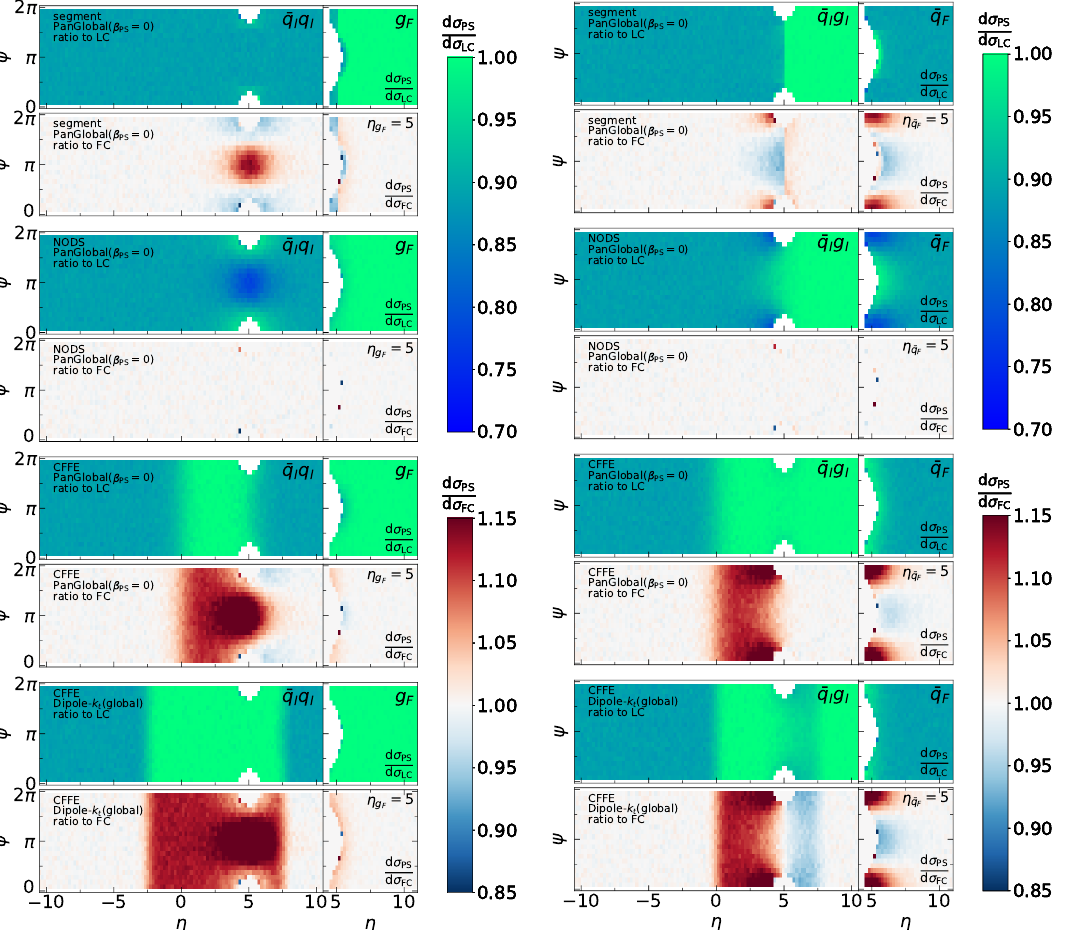
Figure 8. Density for the emission of a soft gluon from a q I ¯ q I → Zg F (left) or g I ¯ q I → Z ¯ q F (right) system in the rapidity-azimuth plane. From top to bottom, the rows show the segment, NODS and CFFE methods with the PanGlobal shower, and the CFFE method with the Dipole- k t shower. For each plot, the upper panels display the ratio between the parton shower differential cross section and the leading colour result, d σ d σ . The LC parton-shower result is obtained PS / LC setting C = 2 C = 3 , i.e. an emission strength C 2 = 3 / 2 for each dipole. The lower panels A F A / show the deviation from the FC differential matrix element, given in appendix C, d σ d σ . PS / FC For each plot, the left-hand panels correspond to emissions from the incoming partons (in the sense of a Cambridge/Aachen algorithm with jet radius R = 1 [92, 93]), whereas the right-hand panels correspond to emissions from the first emitted parton (either g or ¯ q F F